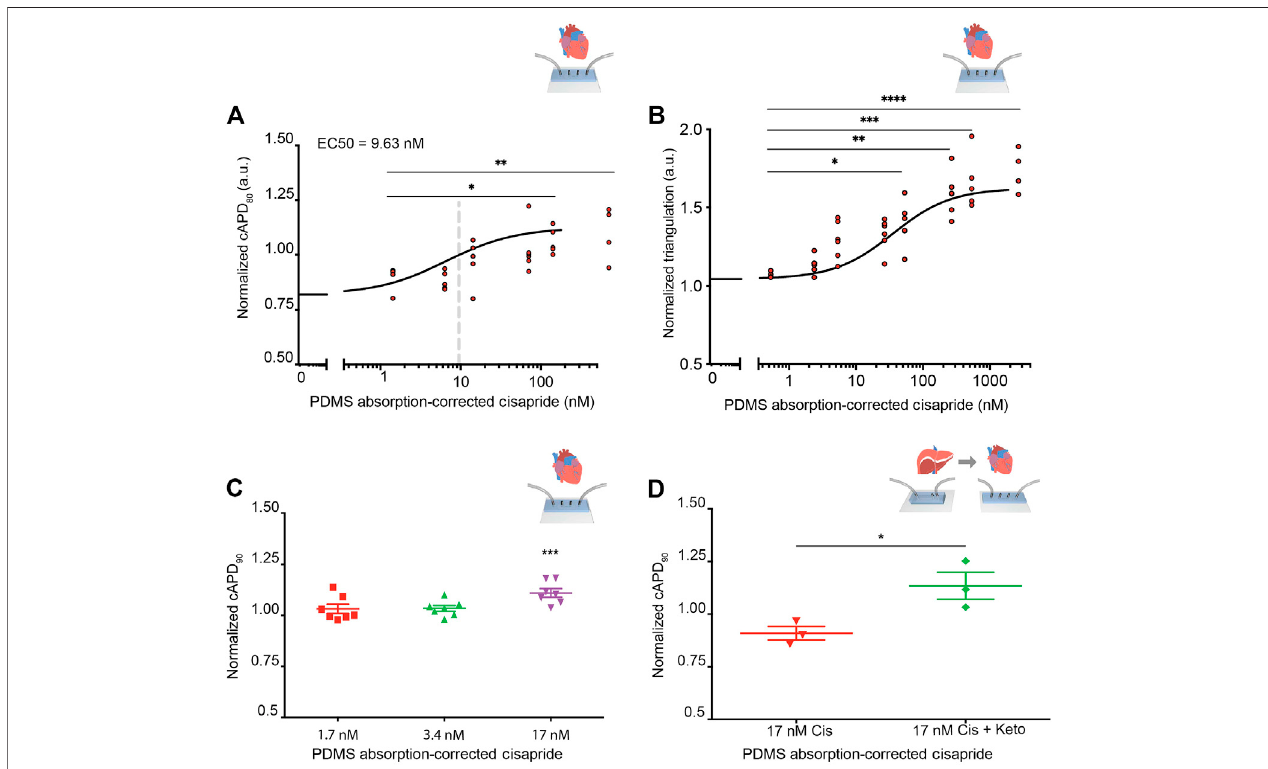
FIGURE 5 | Cisapride effects on cardiac MPS and DDI in integrated liver and cardiac MPSs. (A) Cisapride-induced changes in cAPD 80 in the cardiac MPS. Nonlinearregression fi tlog(inhibitor)vs.response(HillEquationusingthreeparameters)wasusedtoobtainEC 50 value(9.63 nM,grayverticalline).Cisapridevalueswere correctedforPDMSdrugabsorptionof64%.Statisticaldifferencesarebasedonone-wayANOVA( p values:* (cid:2) 0.0259and** (cid:2) 0.0095). (B) Cisapride-inducedchanges inbeatshapeplottedastriangulationvalue(cAPD 80 -cAPD 30 )/cAPD 80 .CisapridevaluesarecorrectedforPDMSdrugabsorptionof64%.Statisticaldifferencesare basedonone-wayANOVA ( p values:* (cid:2) 0.0174,** (cid:2) 0.048,*** (cid:2) 0.0004and **** < 0.0001). (C) Effect ofincreasingconcentrationsofcisaprideoncAPD 90 inthecardiac MPS.ThecAPD 90 valuesofthetreatmentswerenormalized totherespectivevaluesforvehiclecontrols.Dataarepresented asthemean ± standarderrorofmeanforat least six independent experiments. Ordinary one-way ANOVA with Dunnett ’ s correction for multiple comparisons test, *** p < 0.0001. Cisapride values are corrected for PDMSdrugabsorptionof64%. (D) EffectofcisapridemetabolizedinliverMPSoncAPD 90 incardiacMPS.cAPD 90 valuesofthetreatmentswerenormalizedtothe0 nM control values. Data are presented as the mean ± standard error of mean for three experiments. Unpaired Student ’ s t test with equal standard deviation was used, * p < 0.05. Cisapride values are corrected for PDMS drug absorption of